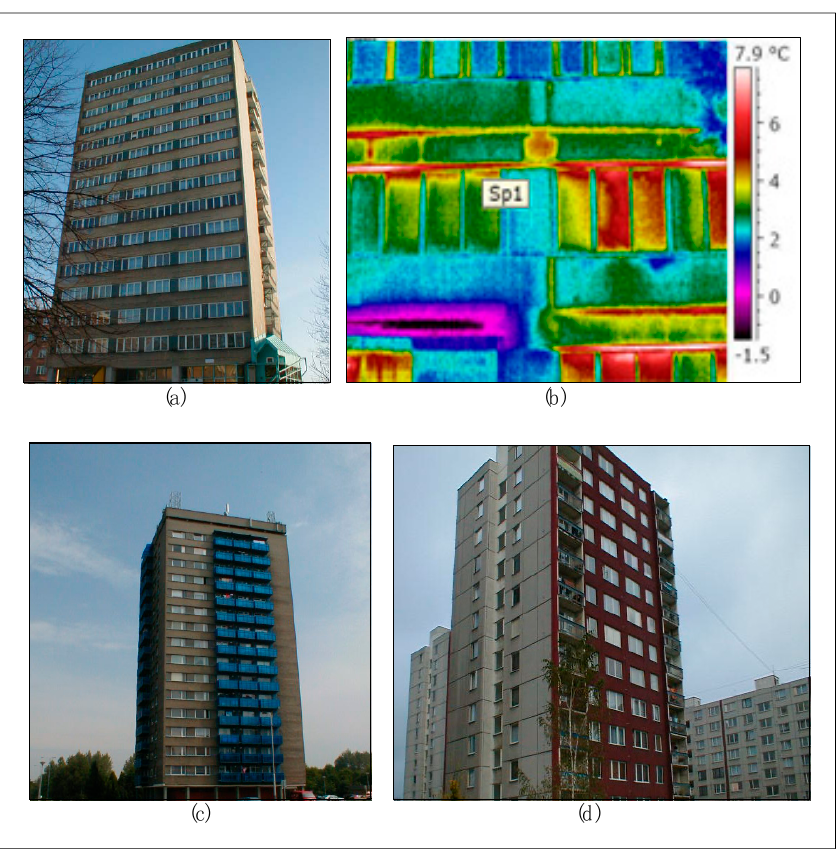
Figure A2. Prefabricated residential housing buildings before renovation: ( a ) VOS system; ( b ) original